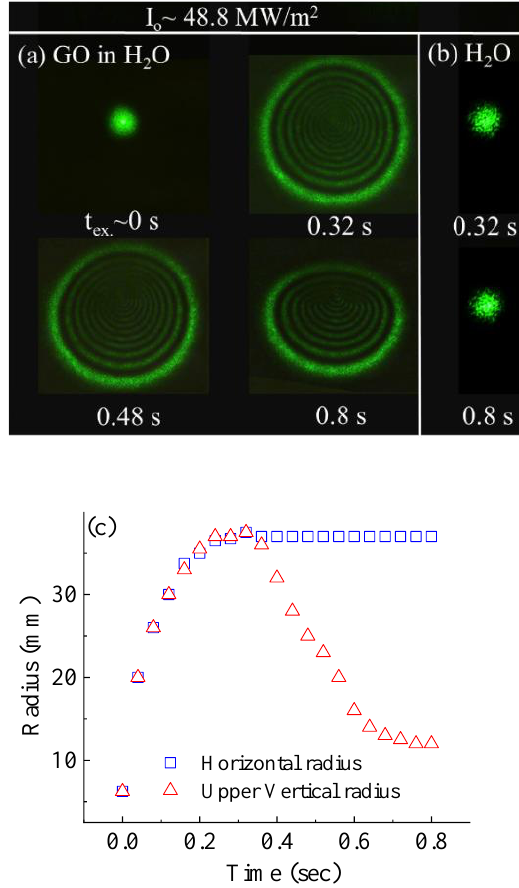
Figure 2. Typical SSPM diffraction patterns at the far field of a Gaussian beam ( a ) through the GO in aqueous base solution and ( b ) through the DI water for different laser excitation times, and ( c ) the horizontal and upper vertical radii of diffraction profiles as a function of laser excitation times. The applied intensity of I o ~ 48.8 MW/m 2 was used for ( a ), ( b ), and ( c ). The data points for horizontal and vertical radii until 0.2 s are completely overlapped in ( c ).